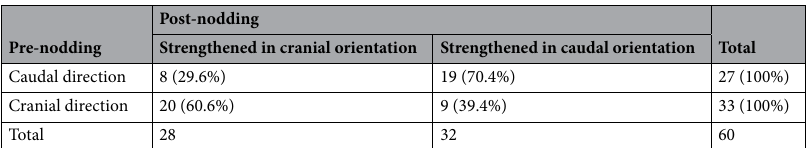
Table 5. Change tendency in CSF stroke volume orientation for both initial orientation states following the one-minute head-nodding period (n = 60). Chi-square test, χ 2 = 5.725(continuity correction), p value = 0.017.